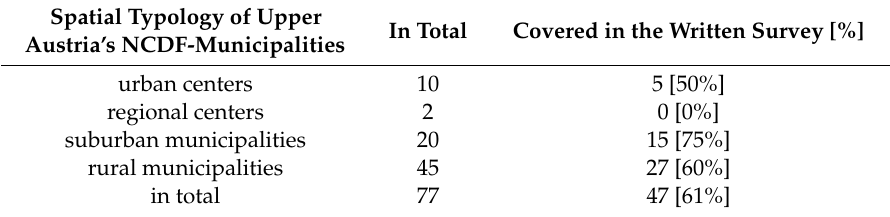
Figure 2. Spatial organization structure of the Upper Austrian NCDFs (as of 2017). The dark colored and bordered areas (referred to as eponymous municipalities) show NCDF-municipalities without further cooperation municipalities. The light gray colored municipalities (referred to as partner municipalities) together with the respective eponymous municipalities (=dark colored areas) constitute a nursing care discussion cluster (=regional NCDF-cooperation). The borders mark the delimitation of the nursing care discussion clusters which consist of neighboring municipalities. The hatched areas in turn, designate those NCDF-municipalities or nursing care discussion clusters which are covered by the written survey. Table 2. Structure and content of the questionnaire for the written expert